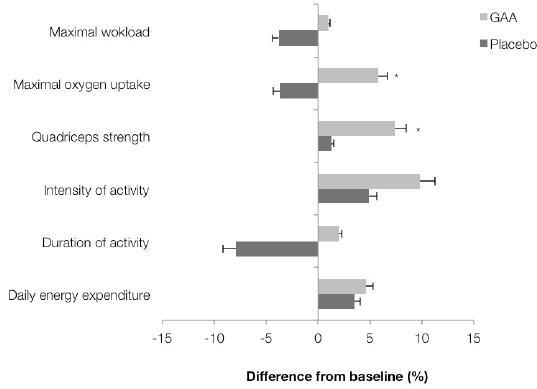
Figure 1. Percentage change in exercise performance end points zero vs. three months. Values are mean ± SD. Asterisk (*) indicates significant interaction effect (treatment vs. time) at p < 0.05. Table 2. Changes in serum and urinary guanidines, and muscle metabolites during the study. Values are mean ± SD.